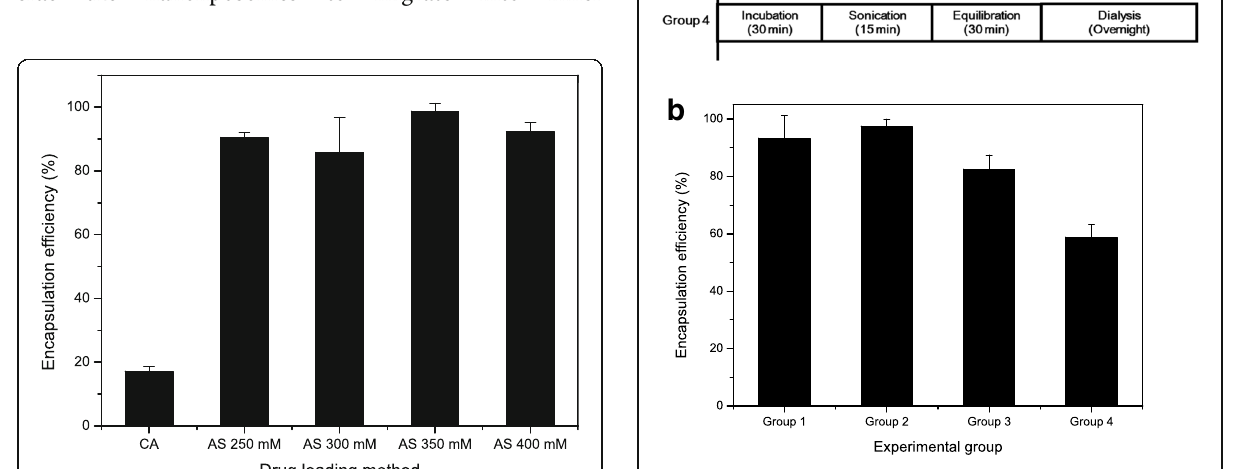
Fig. 5 Encapsulation efficiency of DOX in dual drug-encapsulated nanoliposomes according to various drug-loading conditions: drug- loading conditions for each experimental group ( a ) and drug encapsulation efficiencies of the experimental groups ( b ) ( n = 3, the data are presented as mean ±